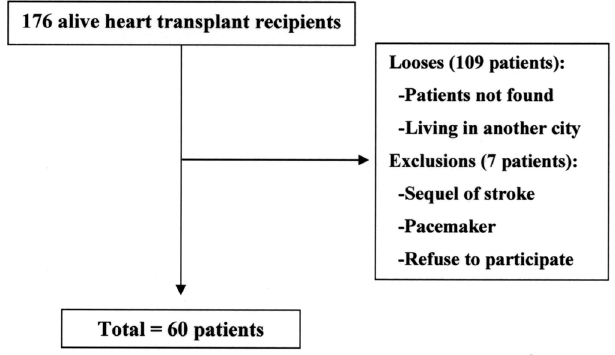
Fig.1 – Patients flow throughout the